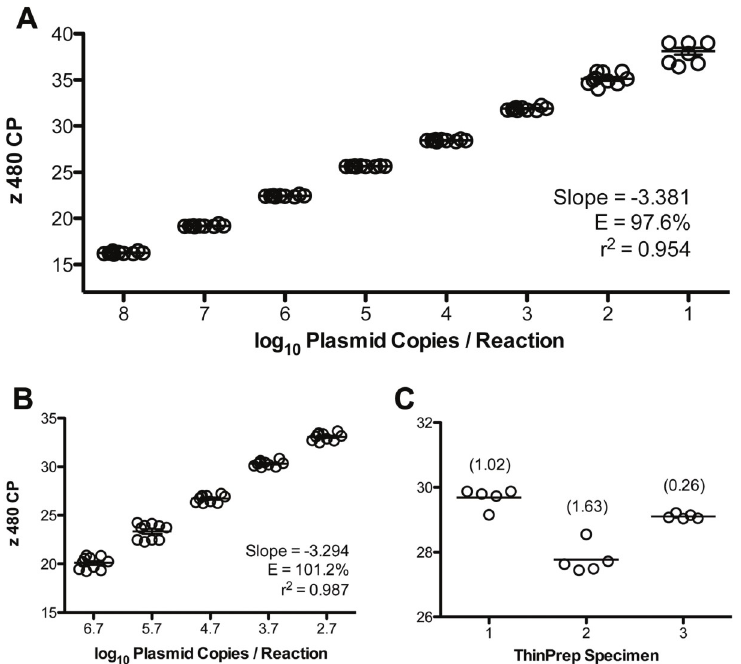
Fig 1. Reproducibility of the T . vaginalis LDT. (A) Intra-assay reproducibility and linearity of target detection was determined using ten replicates of pre-quantified, amplicon-encoded plasmids tested on a single run. (B) Inter-assay reproducibility was similarly assessed among ten LDT runs conducted over a five-week period. (C) Reproducibility of the entire LDT workflow was assessed using replicate DNA preparations (n = 5) of three T . vaginalis -positive ThinPrep PreservCyt specimens. Data are presented as crossing point (CP) values with % coefficient of variation among the replicates in parentheses. Slope, PCR efficiency (E), and r 2 values are presented for the extended reproducibility data in panels A and